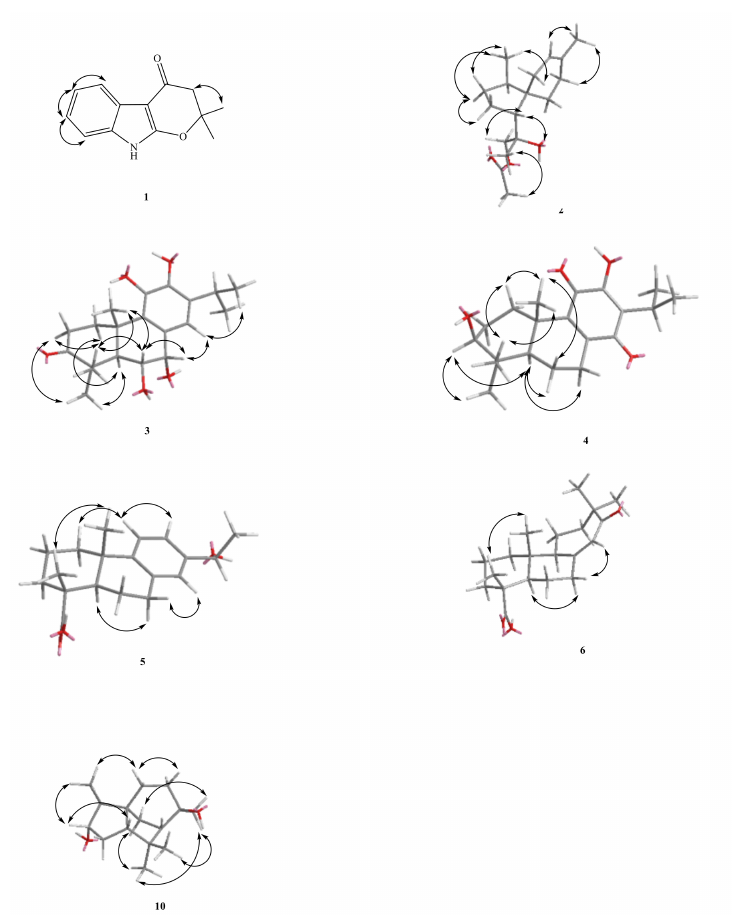
Figure 3. Major NOESY ( ↔ ) contacts of 1 – 6 and 10